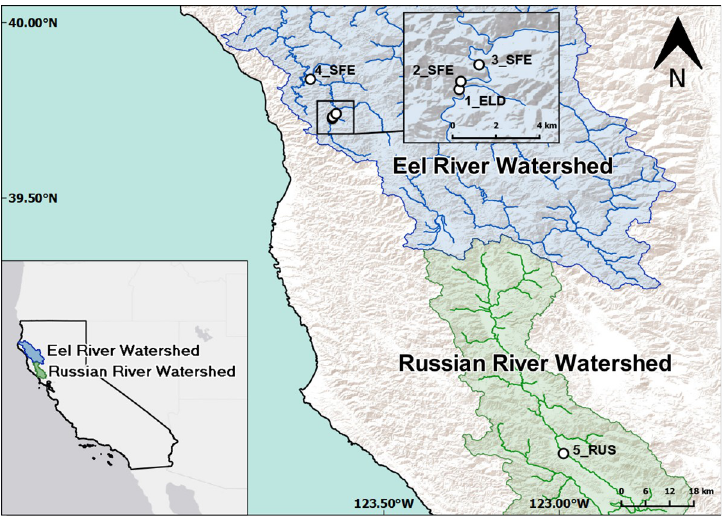
Fig 1. Map of sampling sites on the South Fork Eel River and on the Russian River in California, USA. Blue areas on the map refer to the Eel River watershed, while green denotes the Russian River watershed. Sites are labelled in order of increasing drainage area from 1 to 5, while the suffix refers to the river: ELD = Elder Creek, SFE = South Fork Eel, RUS = Russian River.